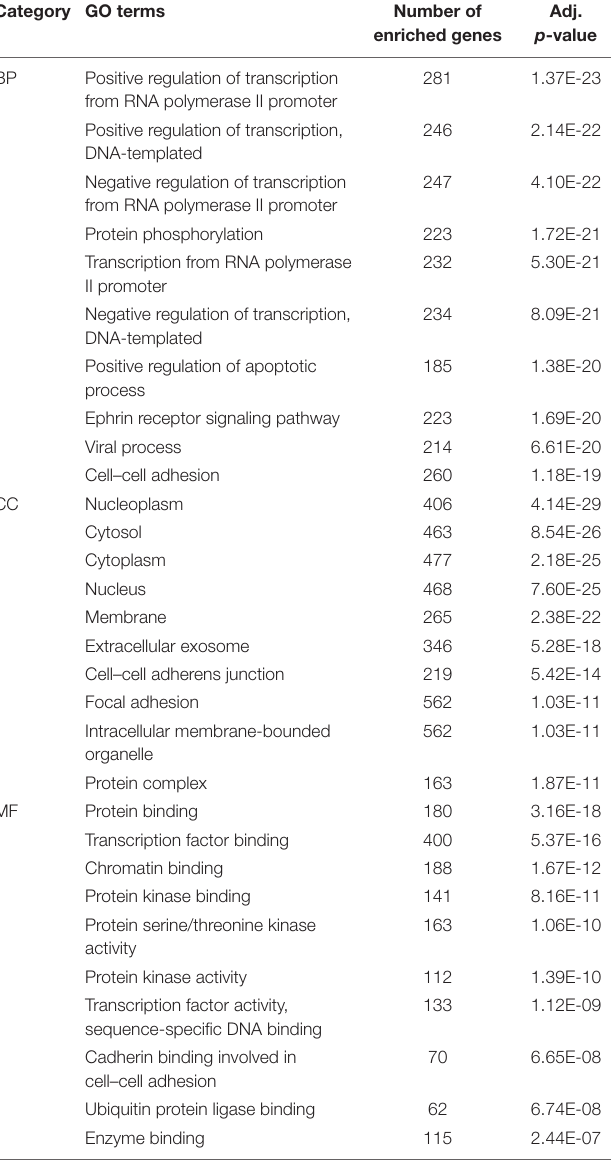
TABLE 2 | The 10 gene ontology terms most significantly enriched by targets of the reported